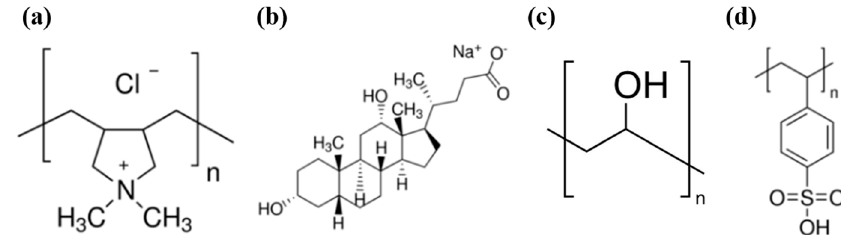
Figure 1. Chemical structures of ( a ) poly(diallyldimethyl ammonium chloride) (PDDA), ( b ) sodium deoxycholate (DOC), ( c ) poly(vinyl alcohol) (PVA), and ( d ) poly(4-styrenesulfonic acid) (PSS). 2.2. Layer-by-Layer Assembly